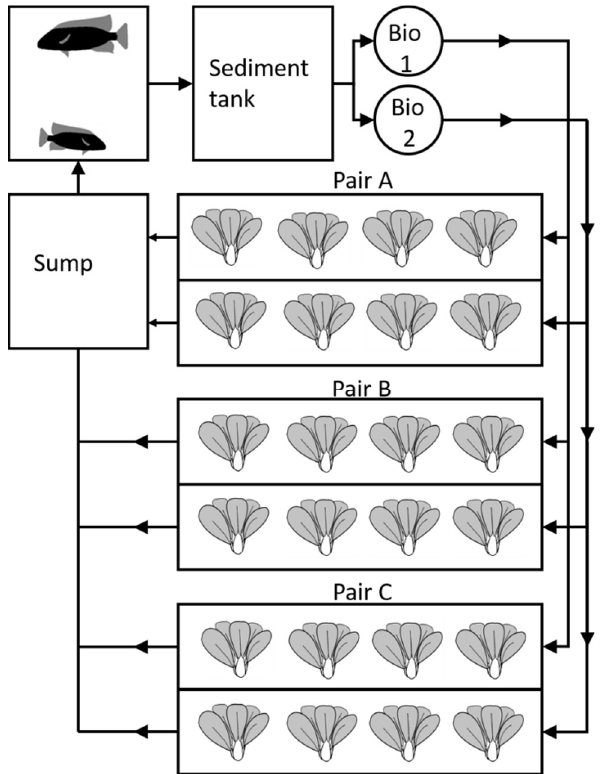
Figure 3. Schematic representation of System 4 used for testing different water flow rates through the plant beds. Flow rates through growbeds in Pairs A, B and C were 500, 160 and 40 L/h, respectively. Tilapia and pak-choi were cultured in this system.